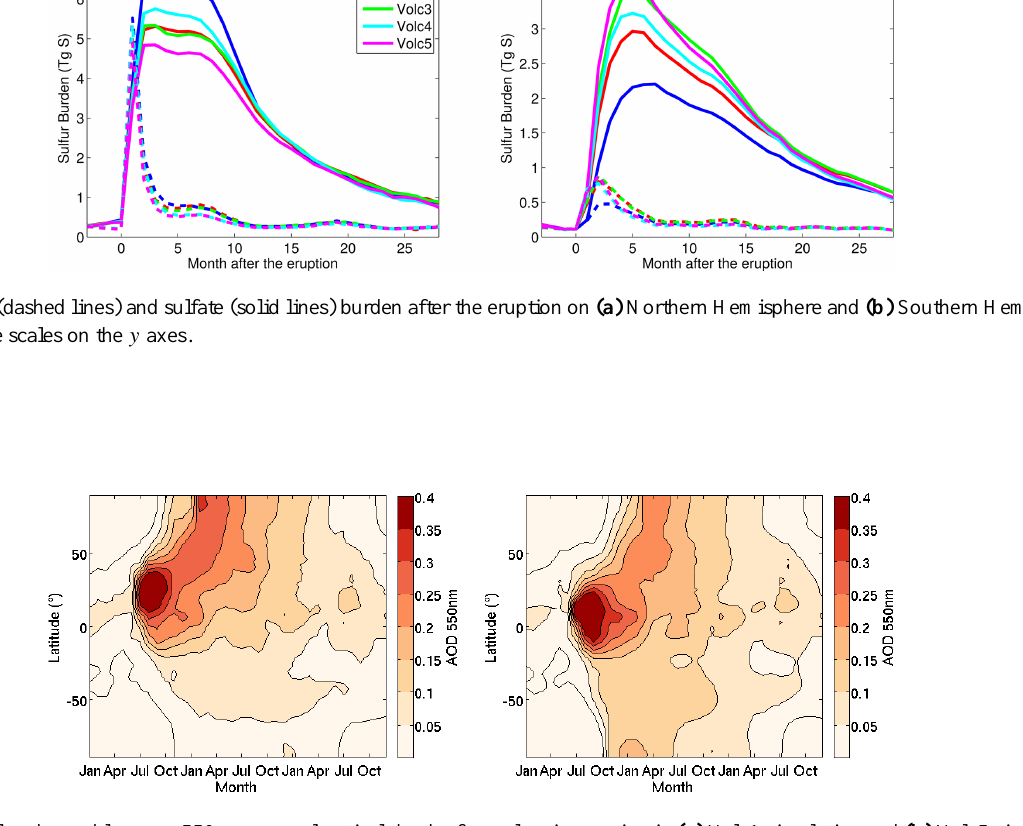
Atmos. Chem. Phys., 16, 305–323, 2016